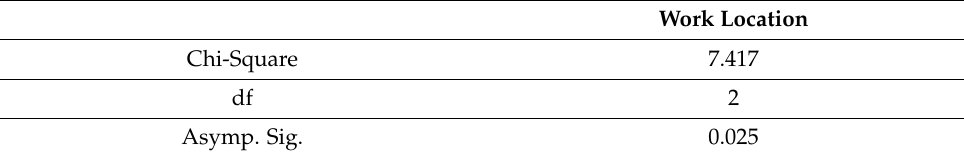
Table 10. Kruskal–Wallis test results for work location.